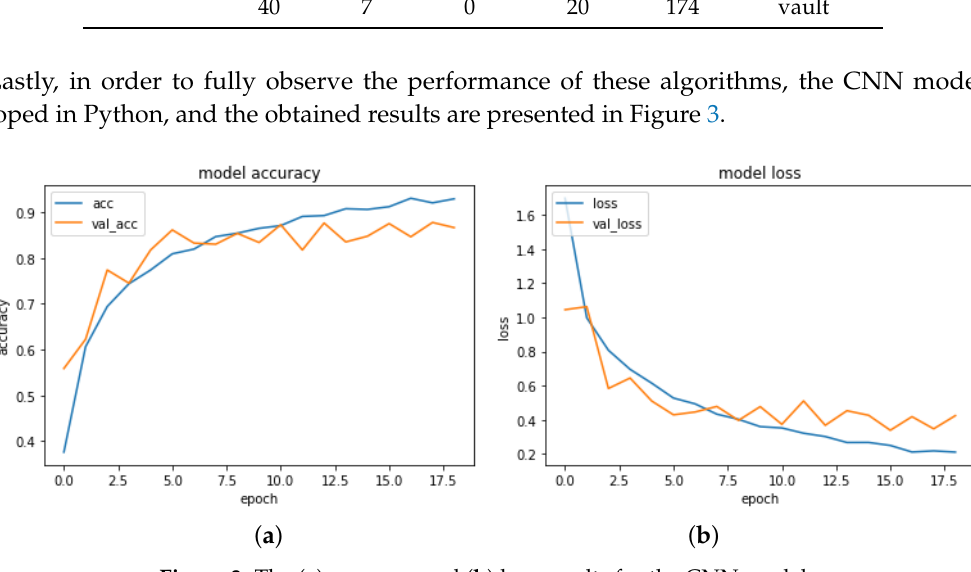
Figure 3. The ( a ) accuracy and ( b ) loss results for the CNN